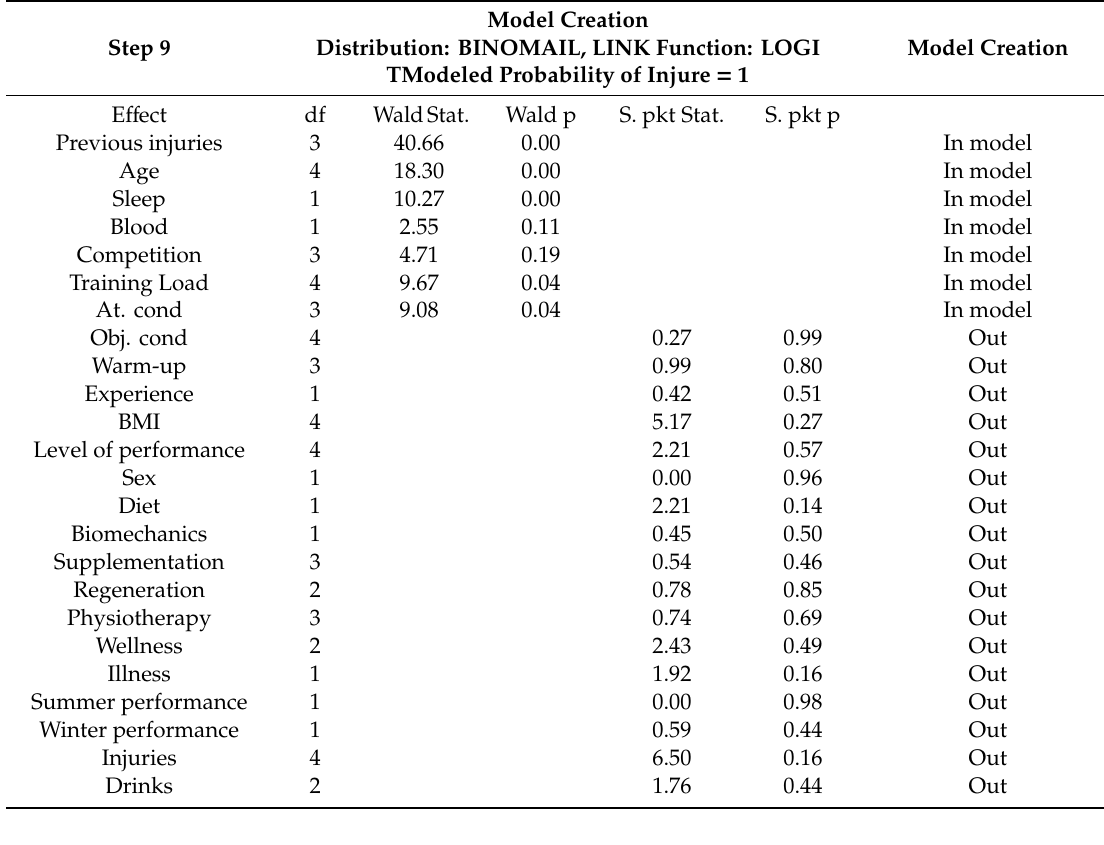
Table 2. Modeled probability of injury using binomial and link distribution and logit function.